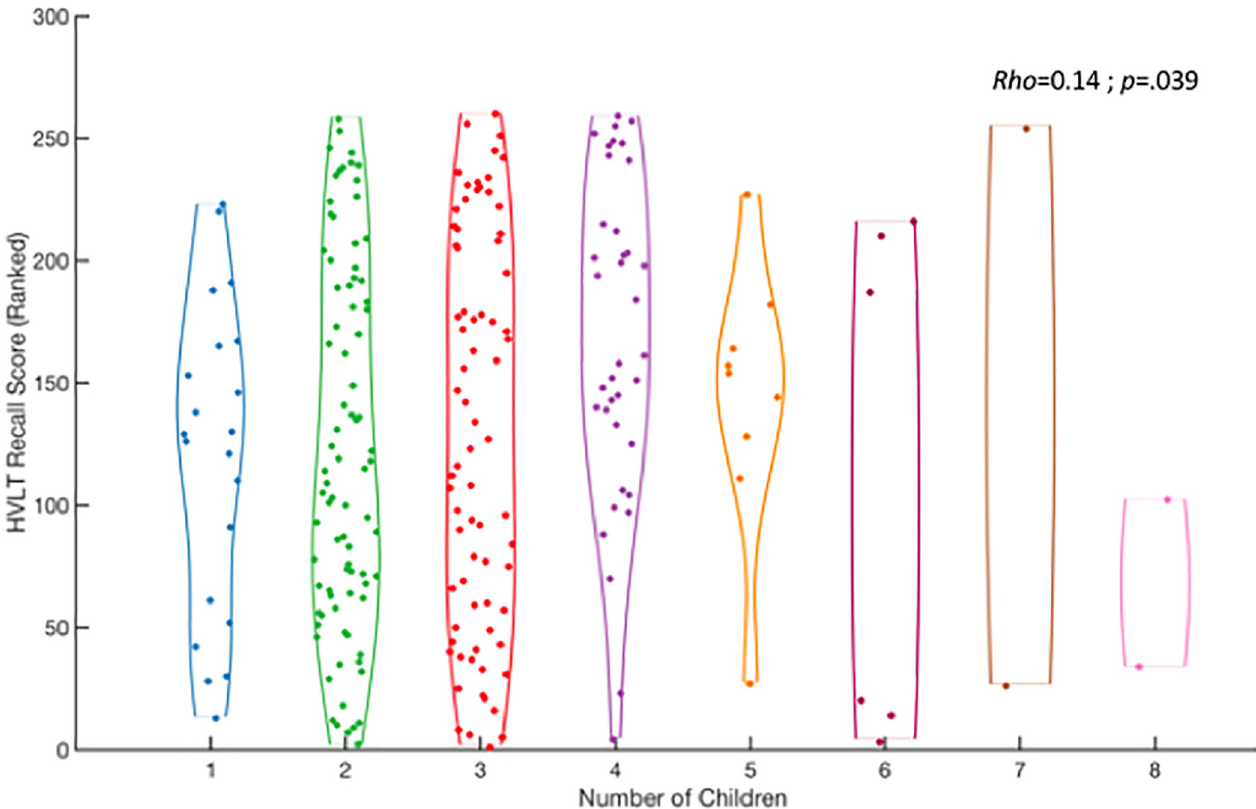
Fig 2. Relationship between Hopkins Verbal Learning Task (HVLT) recall score and the number of children a woman has mothered. HVLT score was first controlled for age and education, then converted to rank, such that each participant’s memory score (N = 260) was converted into rank order (1 to 260).